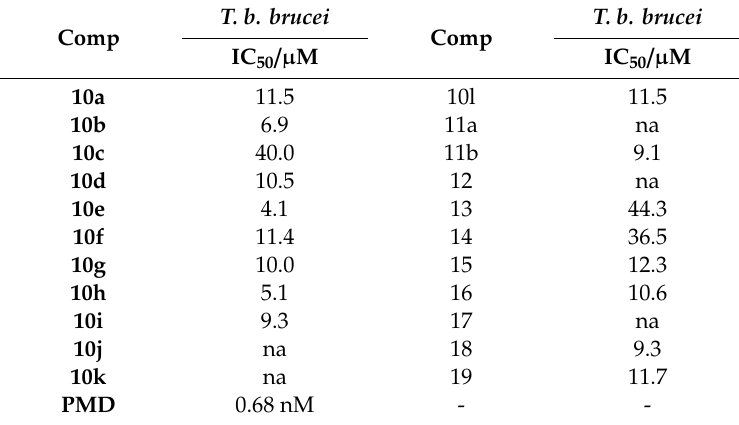
Table 1. In vitro bioassay data for chalcone derivatives 10a – l , 11a – b , and 12 – 19 showing IC 50 values for inhibition of T. b. brucei